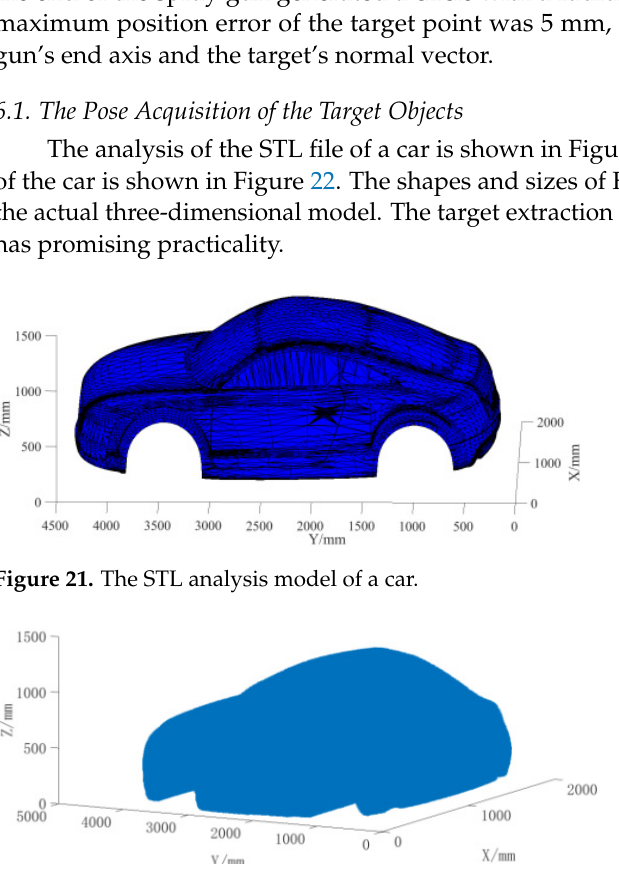
Figure 22. The point cloud model of the car.